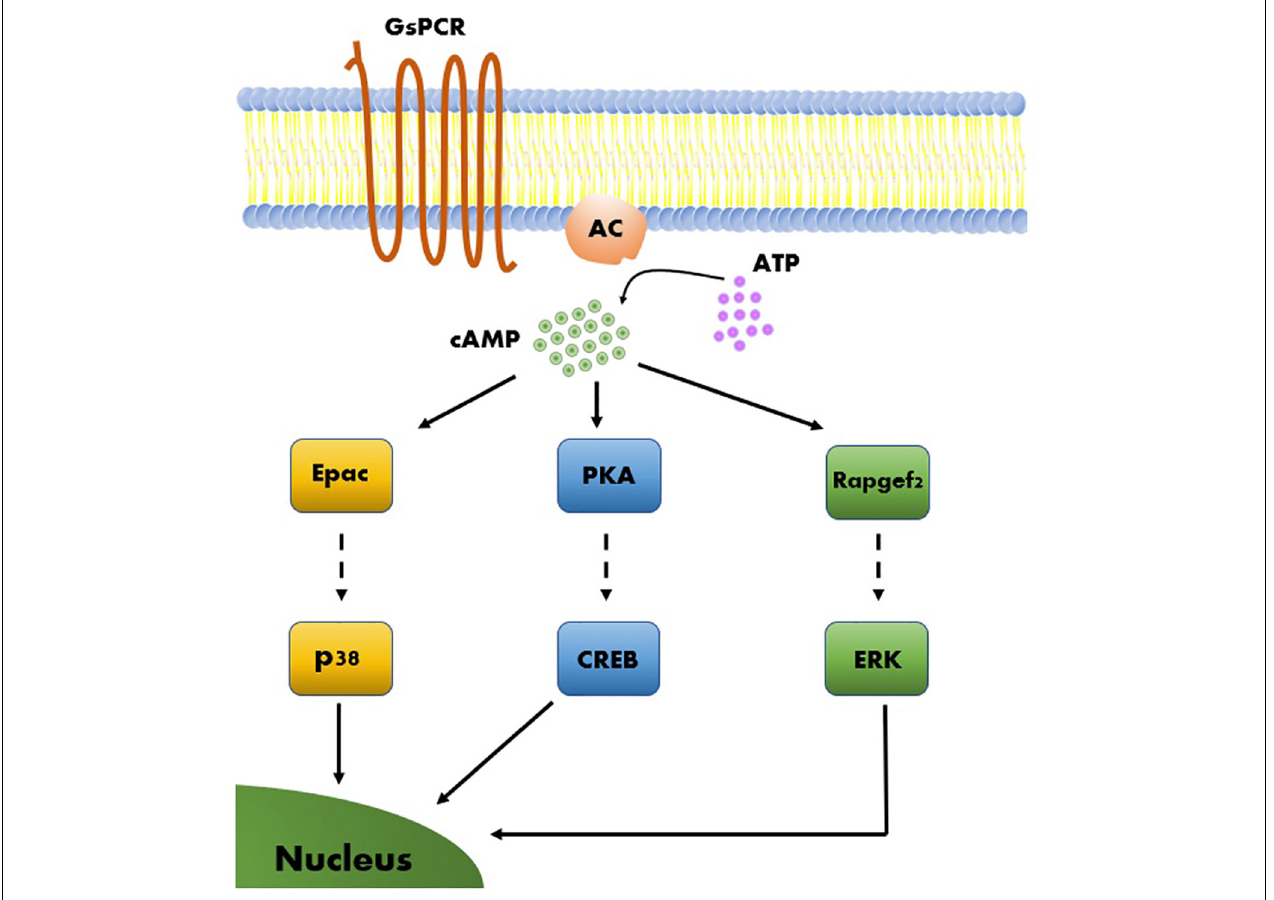
FIGURE 4 | Model of molecular mechanisms of cAMP-dependent LTP. Three cAMP-dependent effectors, Epac, PKA, and Rapgef2, give rise to three parallel molecular pathways. Each of the three cAMP-dependent molecular pathways include a transcription factor that upon activation leads to long-term effects on gene regulation that support synaptic